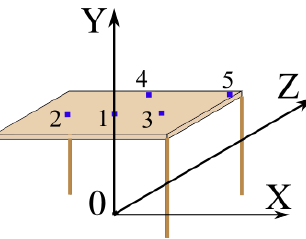
Figure 2. Thermocouples’ arrangement on the panel: 1—point under the GIH; 2—point at a distance of 0.3 m from the GIH center in the longitudinal direction; 3—point on the edge of the table in the longitudinal direction from the GIH center (0.6 m); 4—a point on the edge of the table in the transverse direction from the center of the GIH (0.28 m); 5—a point in the corner of the panel. Table 1. Thermophysical properties of the materials (enclosing structures and panel) used in the experiments [51,52].